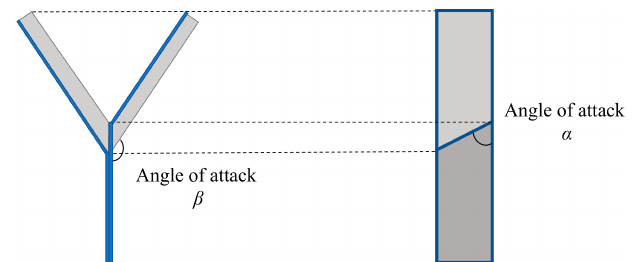
Figure 5. Elevation angle and angle of